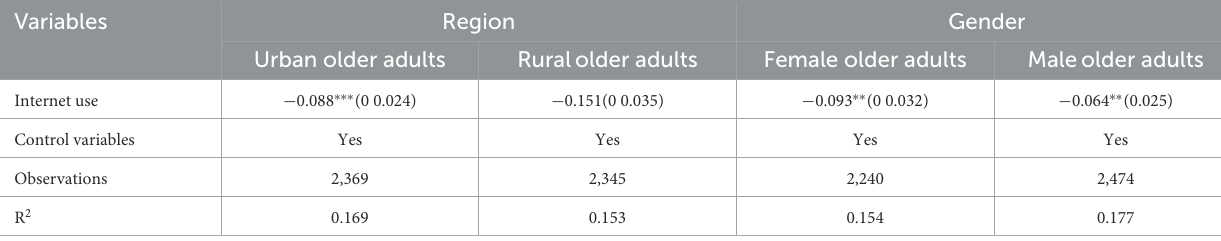
TABLE 6 Results of heterogeneity test of the effect of Internet use on depression among older adults.